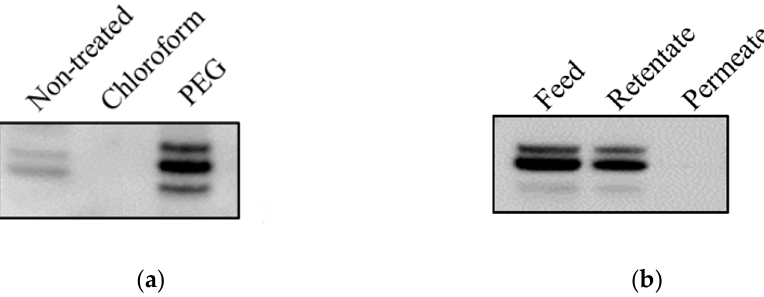
Figure 2. Comparison of non-structural proteins (NSPs) in FMD vaccine antigens prepared by the PEG and chloroform treatment. The O / Boeun / SKR / 2017 virus supernatant was treated with 7.5% ( w / v ) of PEG and 10% ( v / v ) of chloroform. The chloroform-treated virus supernatant was subsequently concentrated by ultrafiltration. After the preparation of vaccine antigen, NSP (3AB) was detected by Western blot analysis using anti-FMDV 3B monoclonal antibody. ( a ) FMD vaccine antigens prepared by PEG or chloroform plus ultrafiltration methods. ( b ) The retentate and permeate samples obtained by ultrafiltration of FMDV culture supernatant without chloroform treatment.